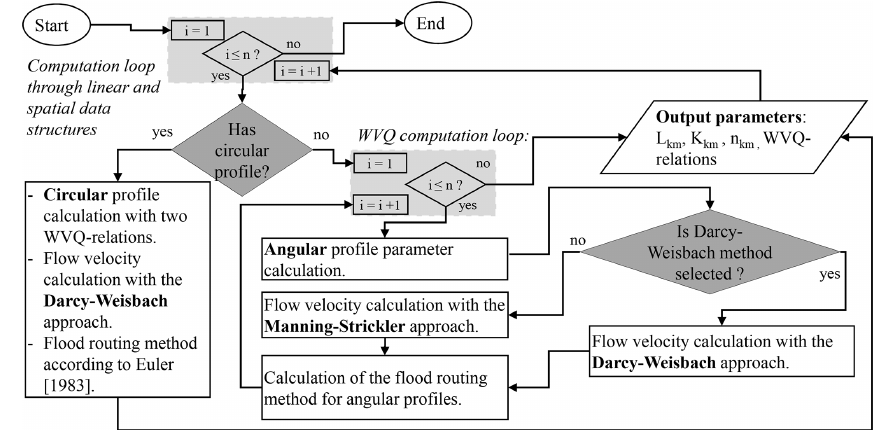
Figure 3. Algorithm to compute the relations between water level, volume and discharge (WVQ) per stream segment.